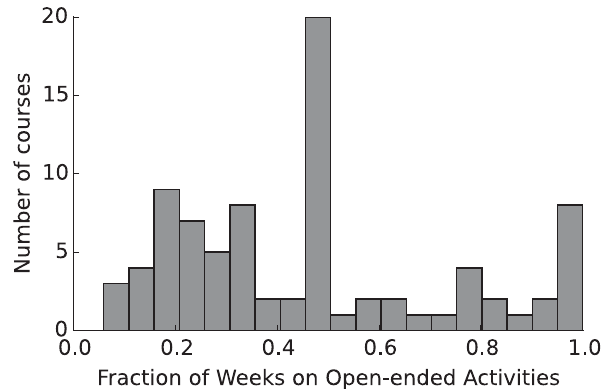
FIG. 1. Histogram of the fraction of weeks spent on open-ended activities for the N ¼ 84 courses that reported including one or more weeks of